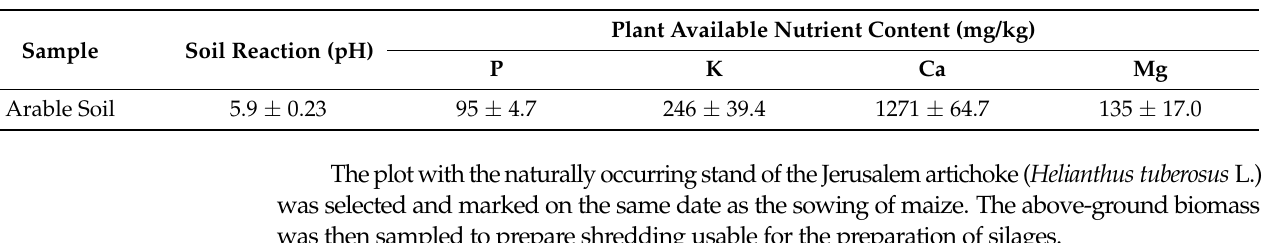
Table 1. Arable soil characteristics from the experimental site (expressed as mean ± SD; for n = 9)— average plant-available nutrient content before application of